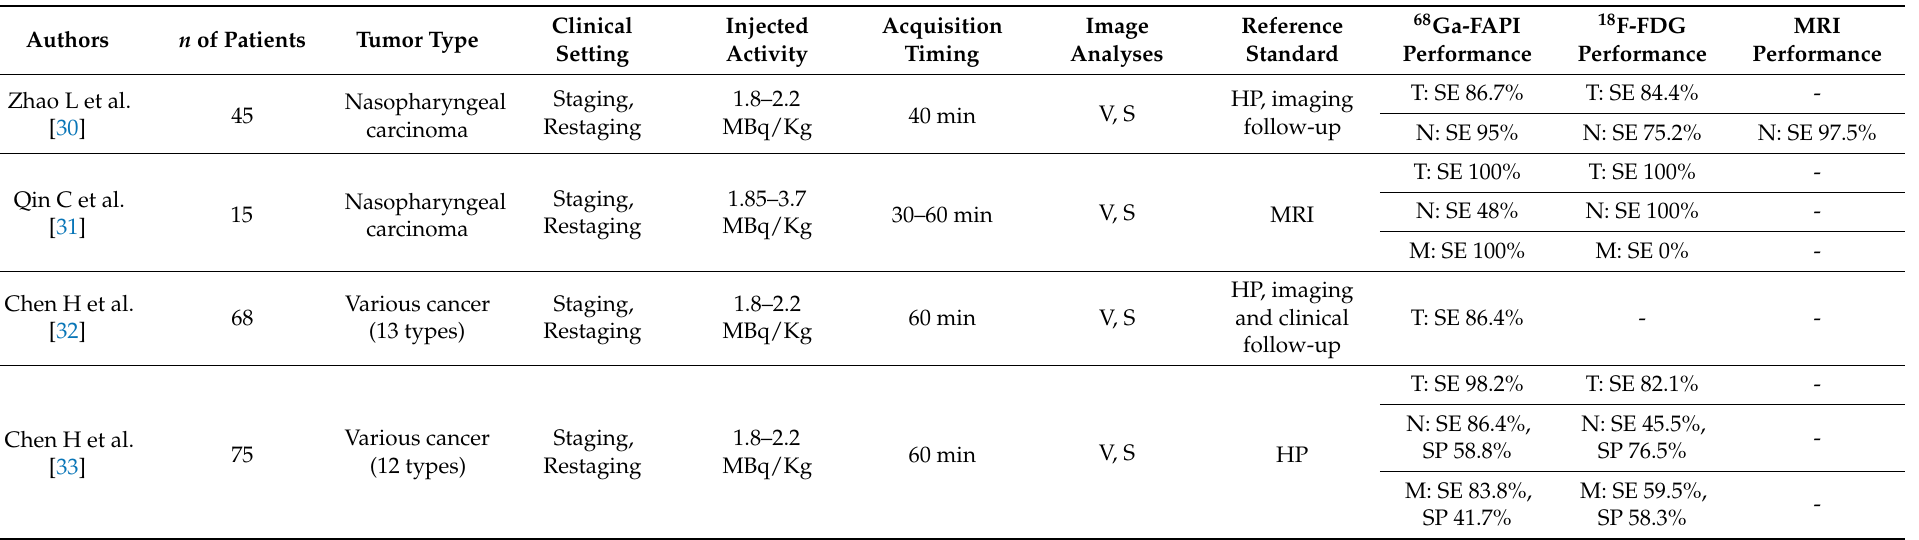
Table 3. Oncological setting: Head and neck